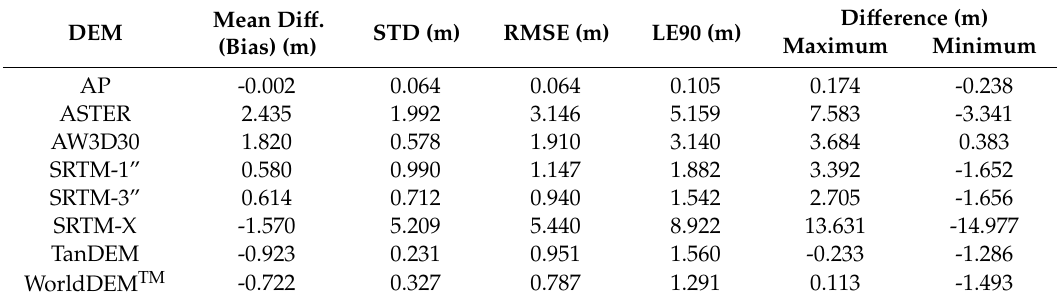
Table 3. Statistics of the di ff erences between the investigated DEMs and the leveled spots on the runway (DEM minus the reference elevation).